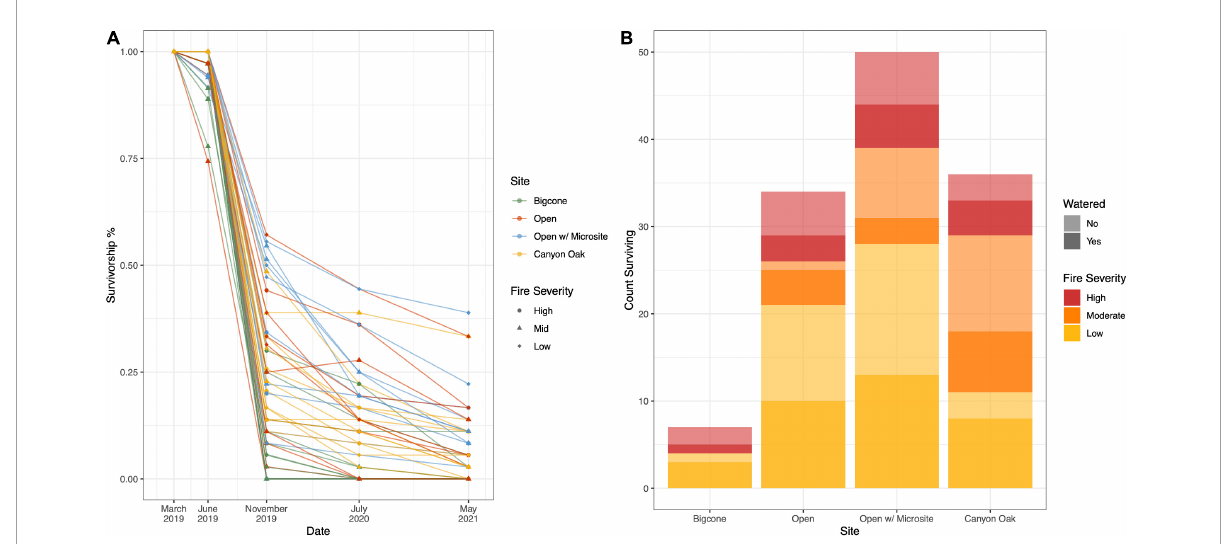
FIGURE3 Seedling survival. Each of these panels depict the overall survival of seedlings throughout the study (March 2019–May 2021). (A) Shows the proportion of seedlings surviving within each planting area, with each microenvironment given a different color and each fire severity level given a different shape. (B) Shows the final count of seedlings surviving after 26 months. Here, seedlings are organized by microenvironment and stacked by fire severity. Within each fire severity bin (red, orange, yellow), seedling counts are shaded by whether or not they received a first summer watering (darker) or not.